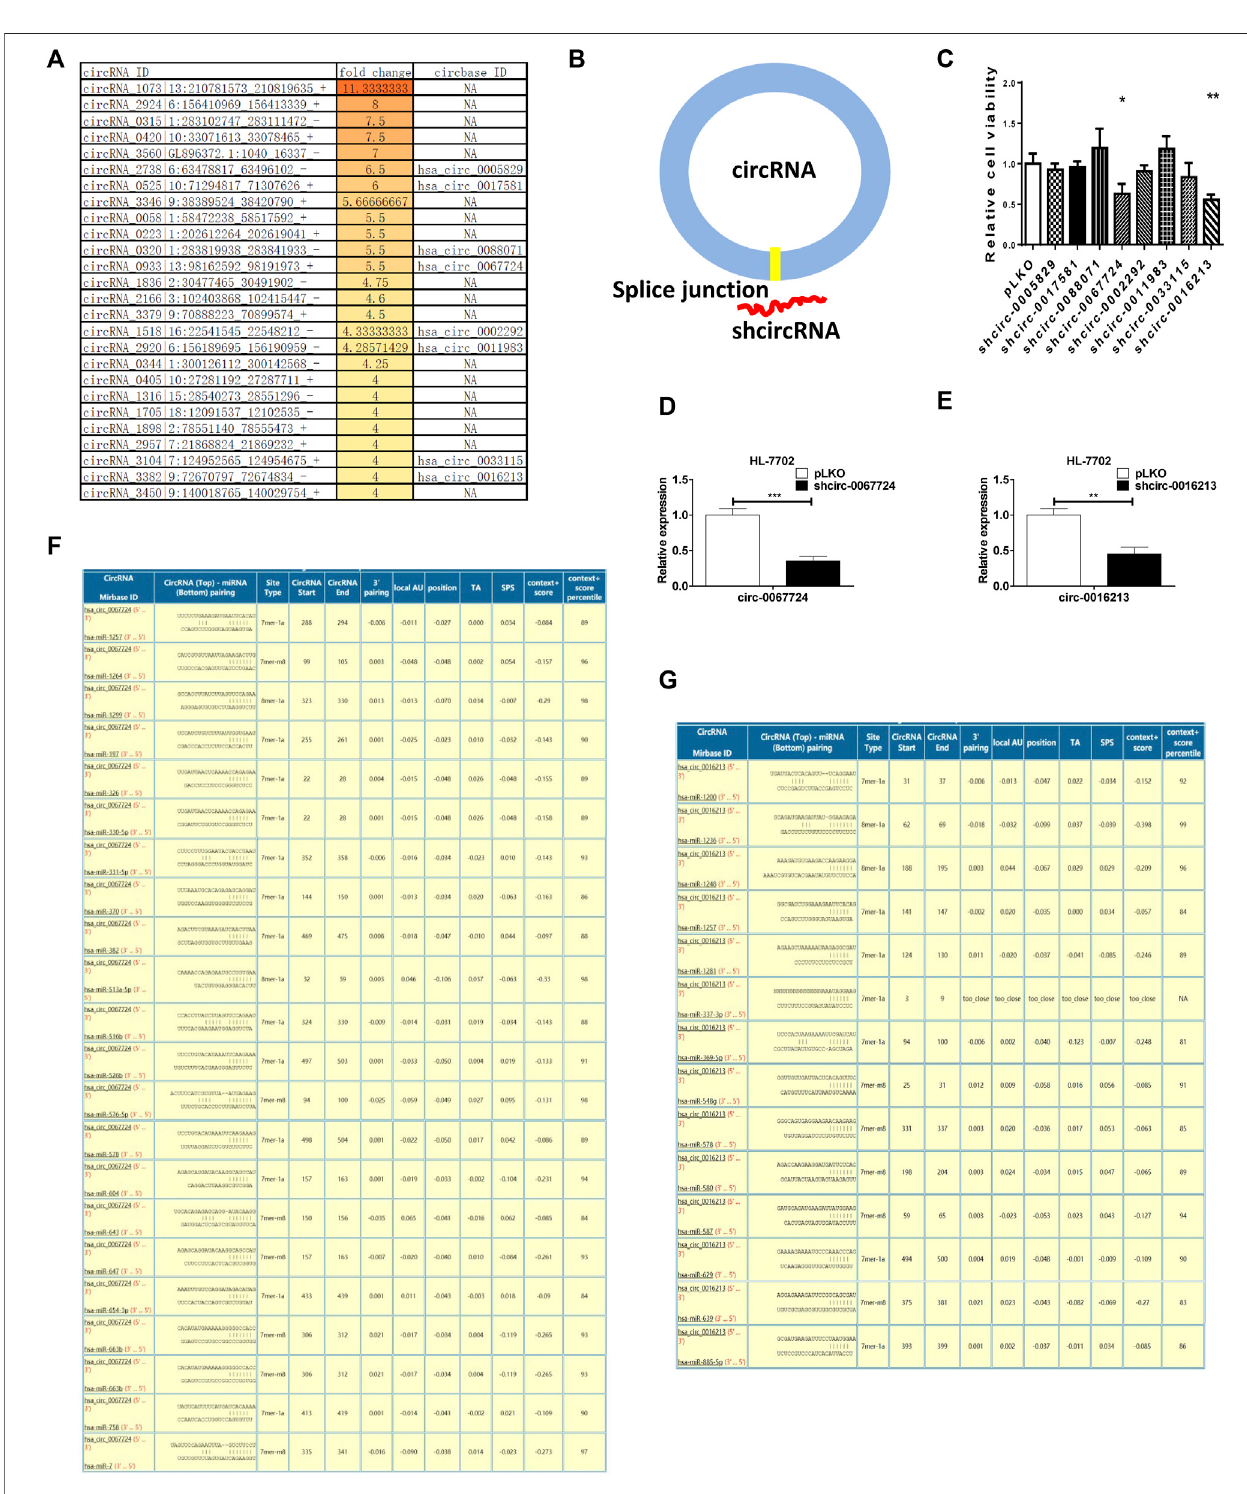
Frontiers in Cell and Developmental Biology |